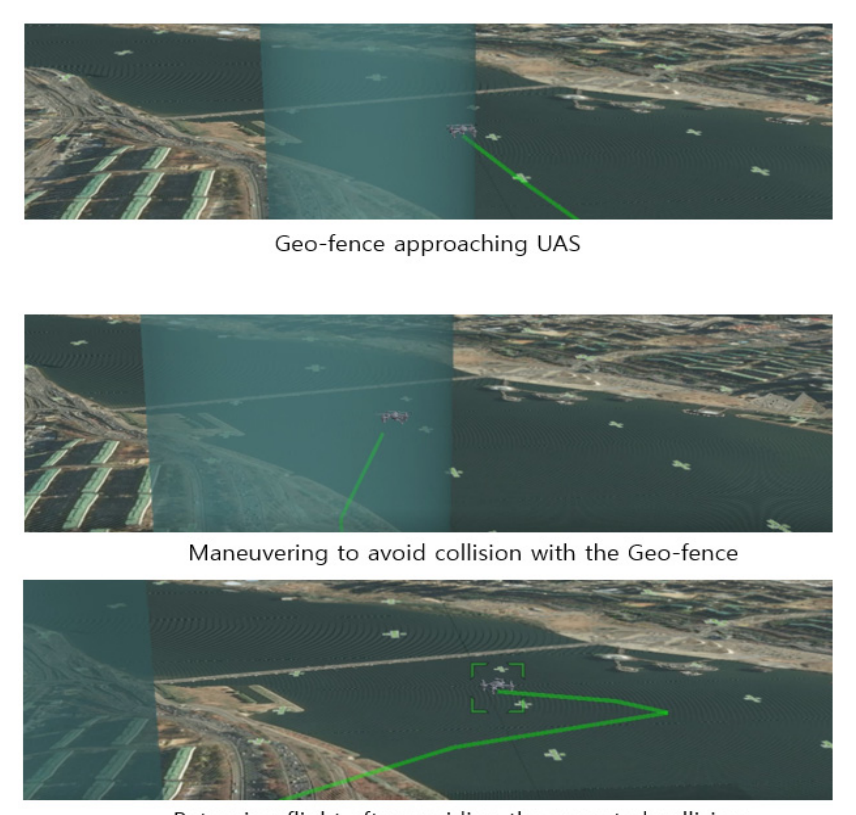
Figure 18. Simulation of Scenario #4 (deconfliction study by altitude).